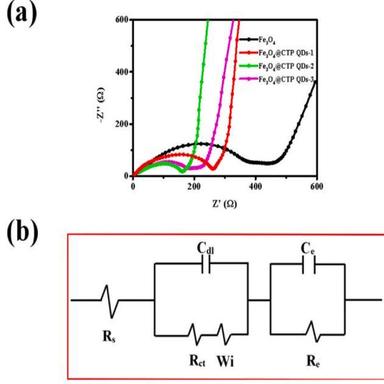
EIS behavior of pure Fe3O4 and Fe3O4@CTP QDs composite electrodes: (a) Nyquist plots; (b) the whole equivalent circuit.